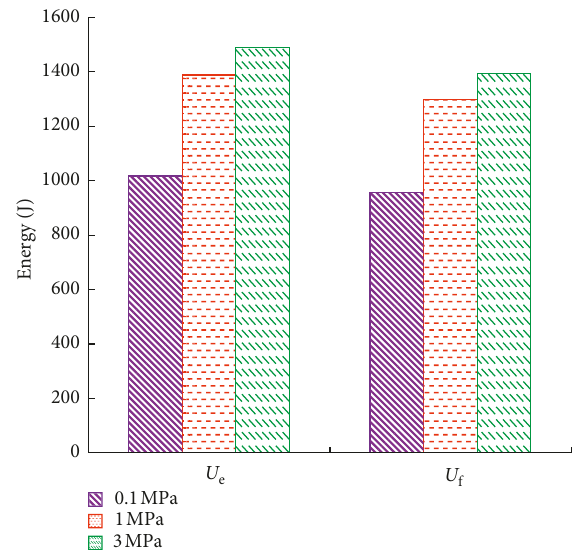
Figure 13: Comparison of the elastic strain energy under different support forces ( U failure and U f is the released energy after rock failure).